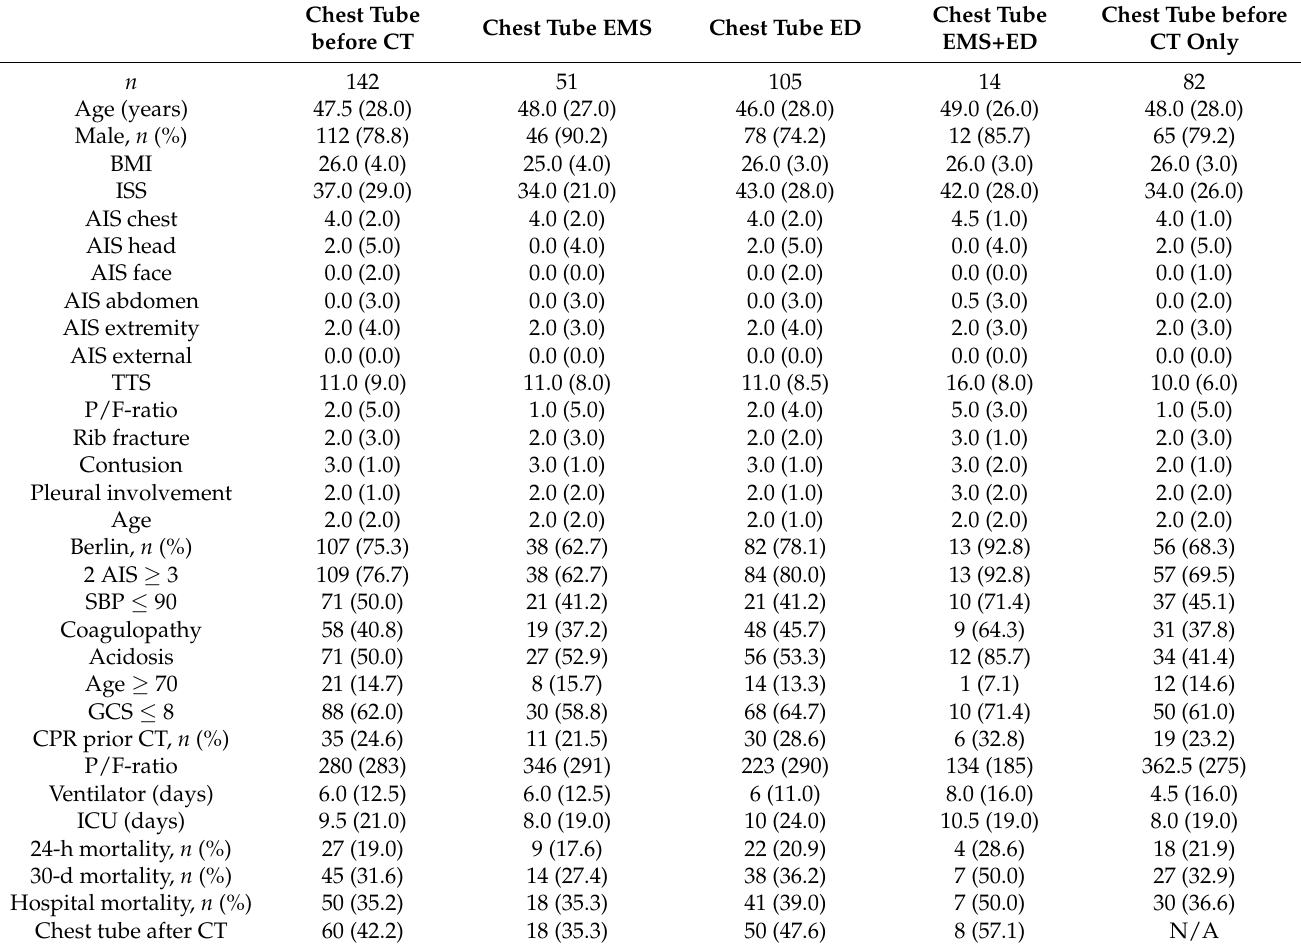
Table 2. Characteristics of patients with chest tube placement before initial computed